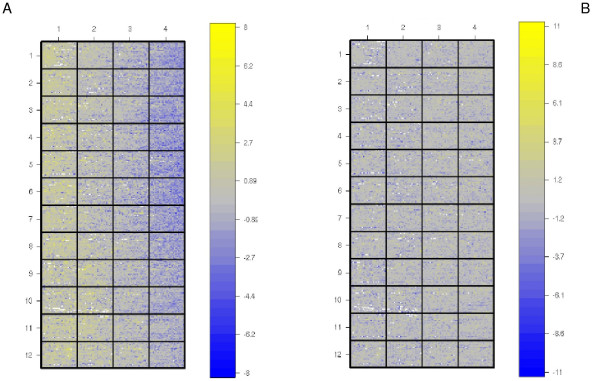
OLIN normalization. OLIN normalization method proposed by Futschik and Crompton [20]. A- The spatial bias effect found. This effect was noted in most of the chips; B- The same slide after